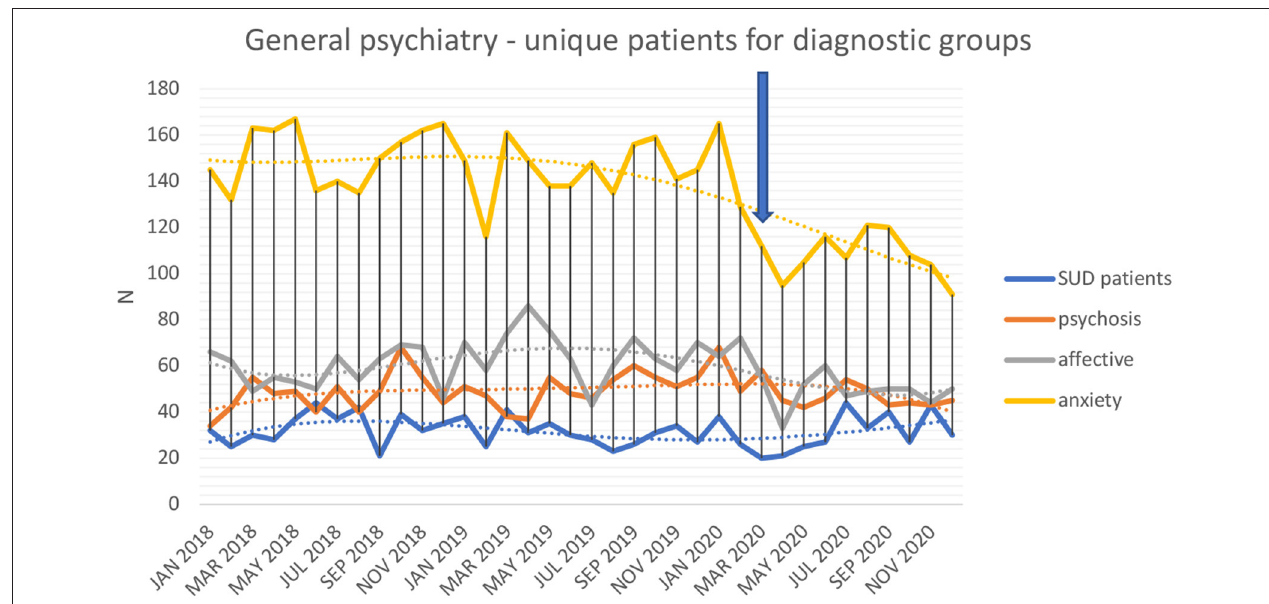
FIGURE 3 | Number of unique patients in general emergency psychiatry with diagnoses of substance use disorders, psychotic disorders, affective disorders, and anxiety-related disorders.